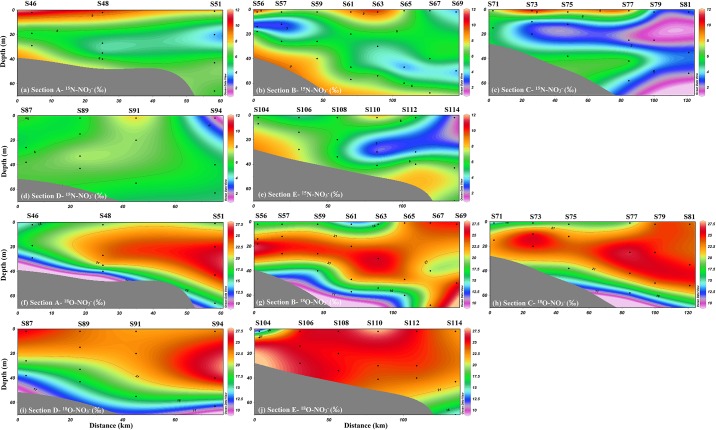
Spatial distributions of δ15N-NO3- and δ18O-NO3- values in the NSCS.